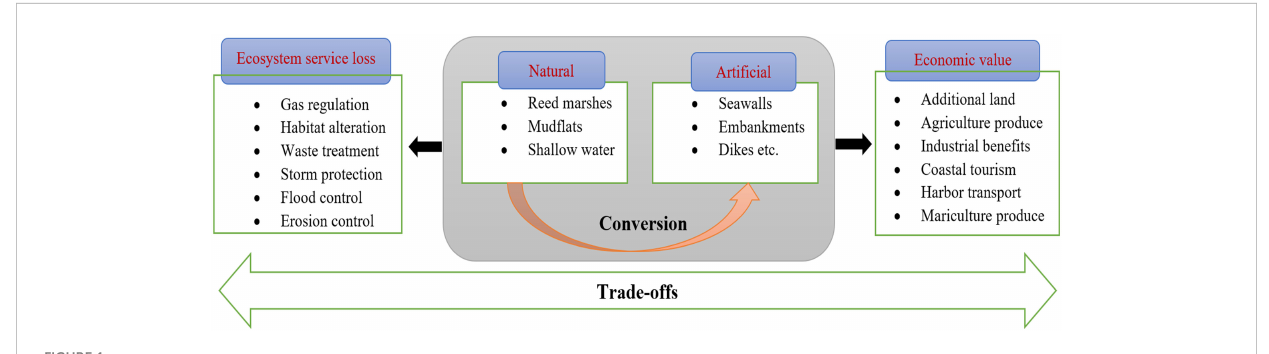
FIGURE 1 Conceptual and methodological